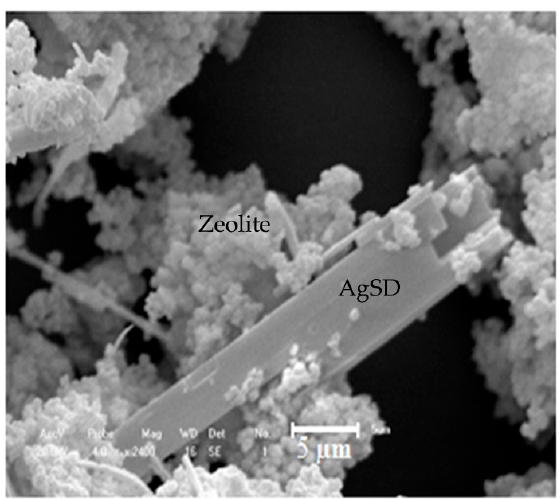
Figure 2. SEM micrograph of AgSD-Y zeolite (magnification of 2400×).